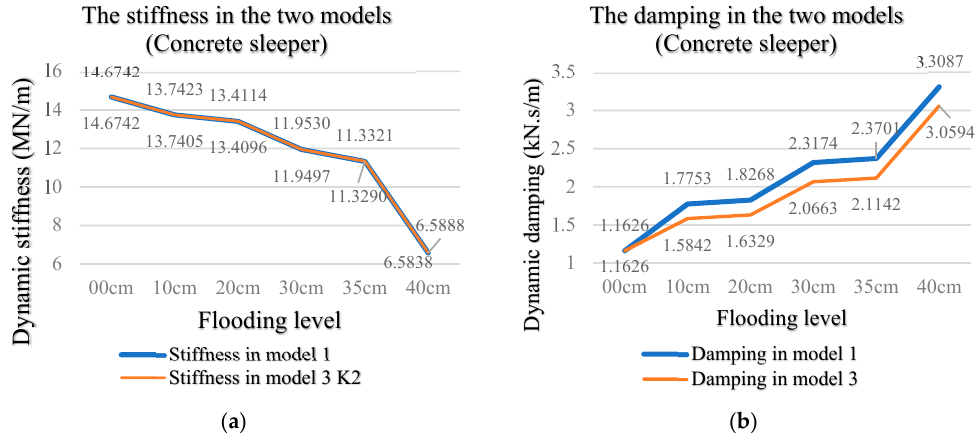
Figure 21. ( a ) comparison of dynamic damping at two models; ( b ) comparison of dynamic stiffness at two models.